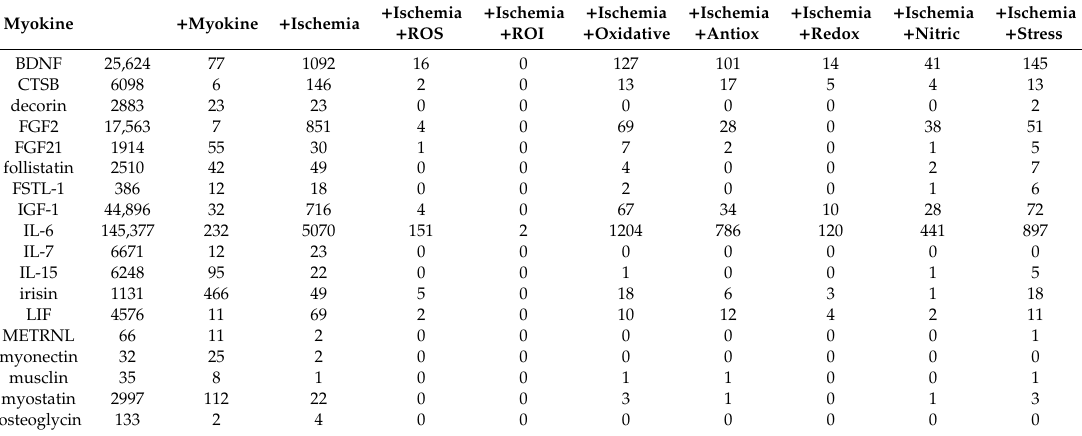
Column 2: total number of articles obtained after searching for certain myokines, respectively. Column 3 and 4: we extended the search with the terms “myokine” and “ischemia”, respectively. Column 5–11: column 2 + the terms “ischemia” and “ROS”, “ROI”, “oxidative”, “antioxidative”, “redox”, “nitric”, or “stress”, respectively. Antiox: antioxidative; BDNF: brain-derived neurotrophic factor; CTSB: cathepsin B; FGF-2: fibroblast growth factor-2; FGF-21: fibroblast growth factor-21; FSTL-1: follistatin-like; IGF-1: insulin-like growth factor-1; IL-6: interleukin-6; IL-7: interleukin-7; IL-15: interleukin-15; LIF: leukemia inhibitory factor; METRLN: meteorin-like, ROI: reactive oxygen